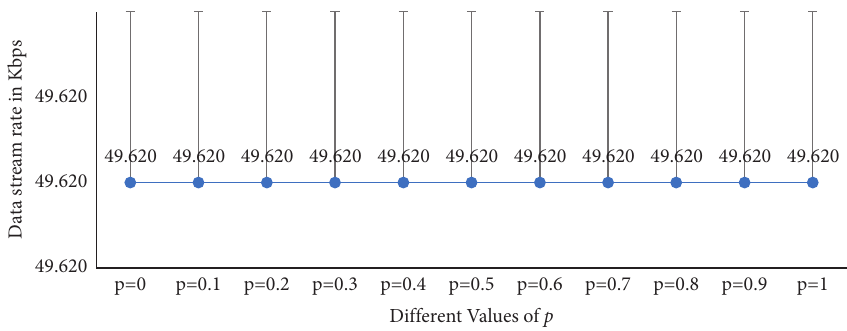
) for server/router 1 when α � 1. 1